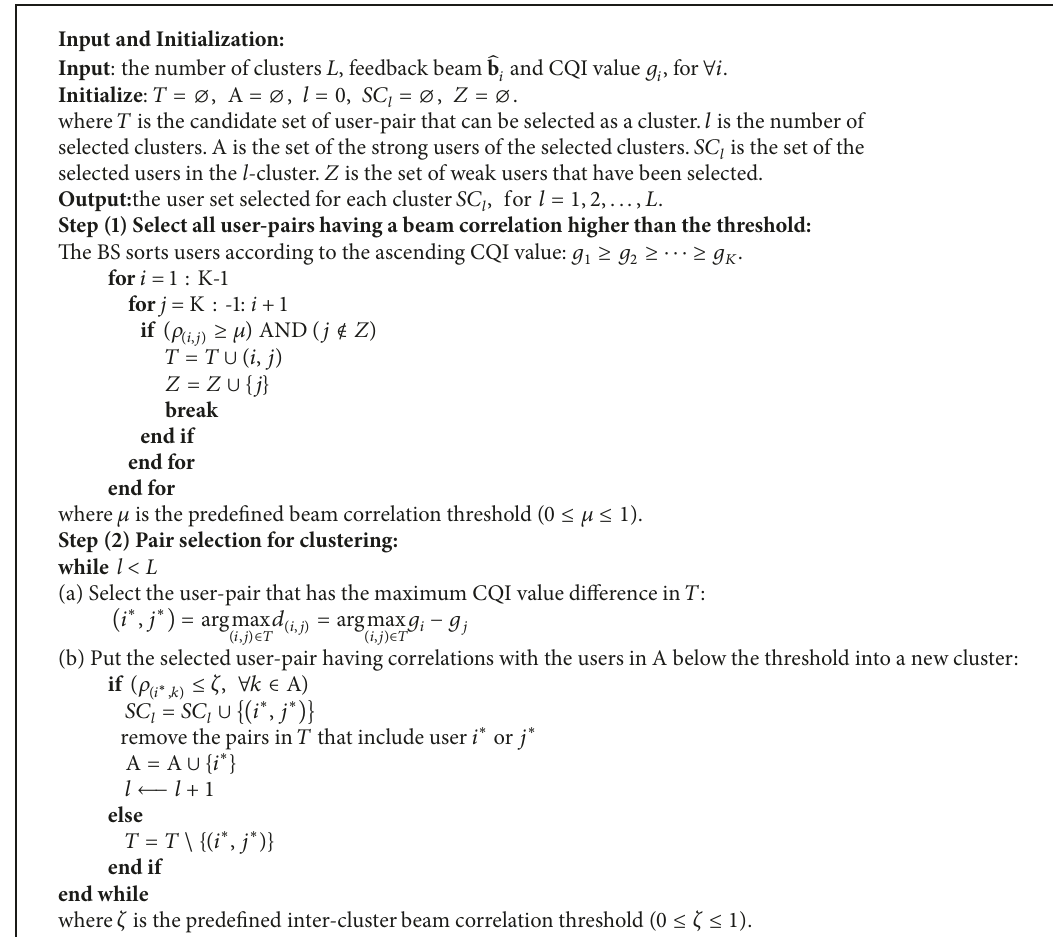
Algorithm 1: User clustering with beam and